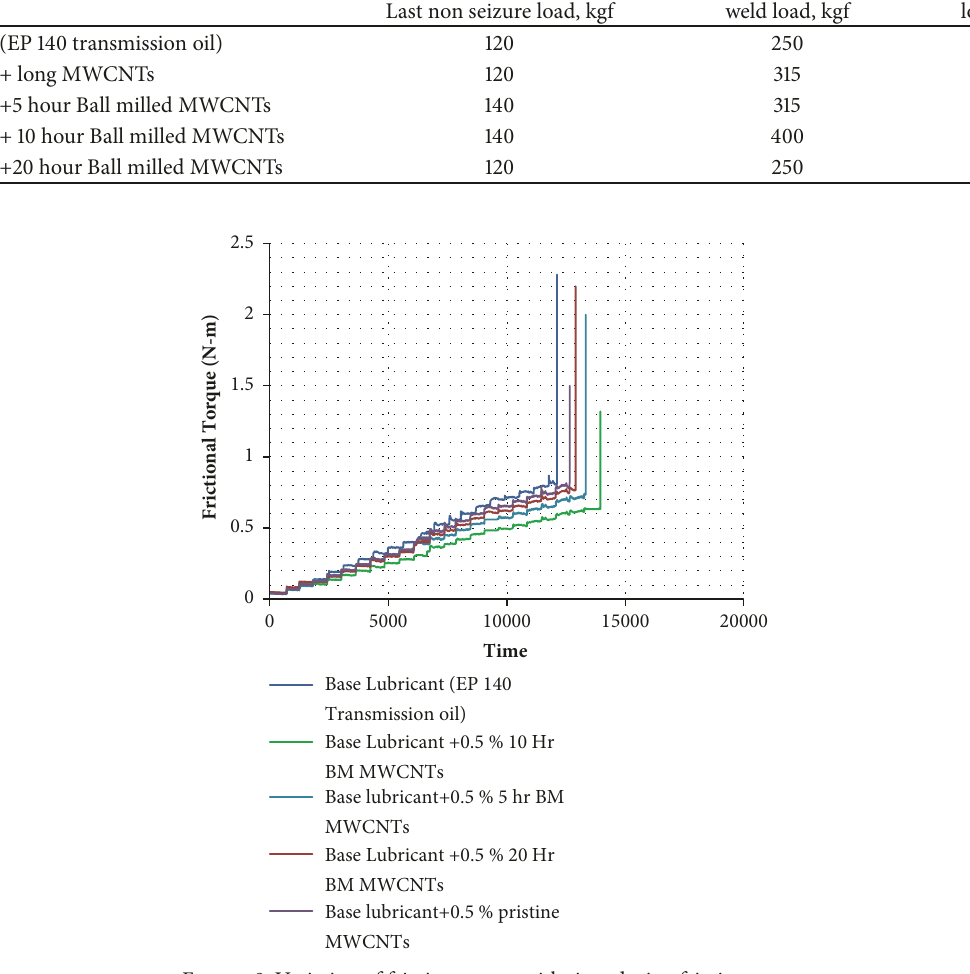
Figure 9: Variation of friction torque with time during friction